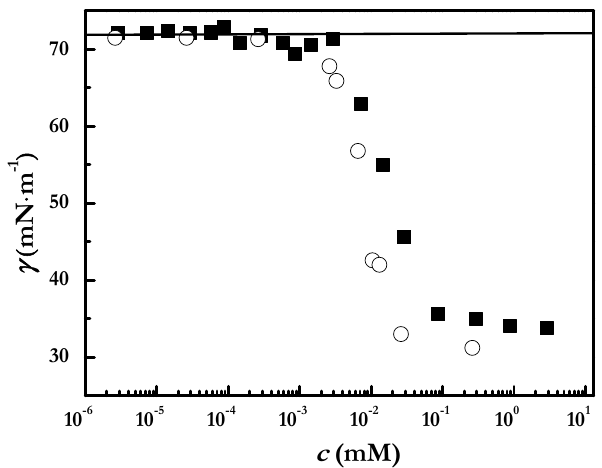
Figure 5. Surface tension isotherms as were obtained using a drop shape tensiometer for PDADMAC–surfactant solutions with a fixed polymer concentration of 5 g/L: PDADMAC–SLMT ( ■ ) and PDADMAC–SLES ( ○ ). The solid lines represent the surface tension of the pure Milli-Q water used in this work. Adapted from Akanno et al. [6], with permission under attribution license Creative Commons 4.0 (2021).